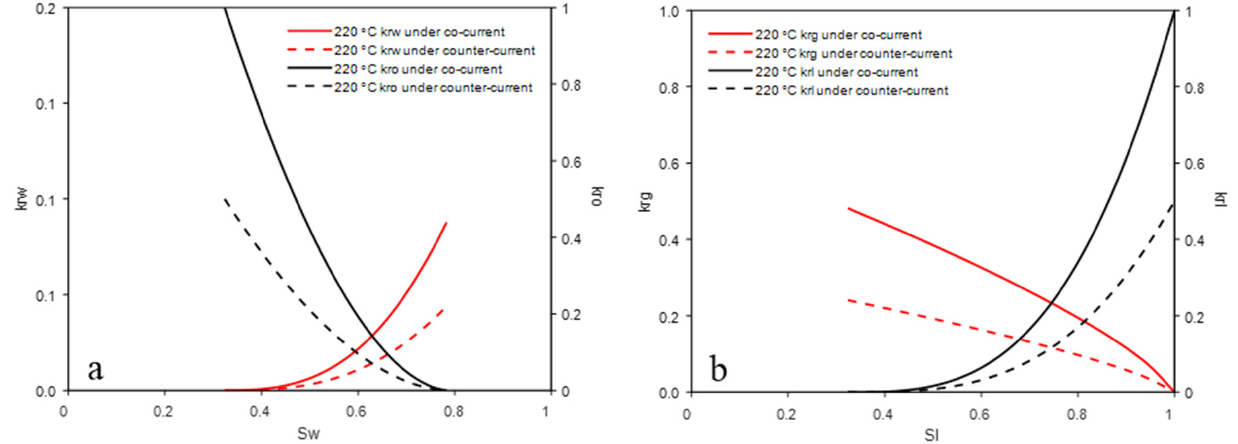
Figure 4. Co- and countercurrent relative permeabilities at 220 °C: ( a ) oil–water relative permeability curves and ( b ) liquid–gas relative permeability curves.